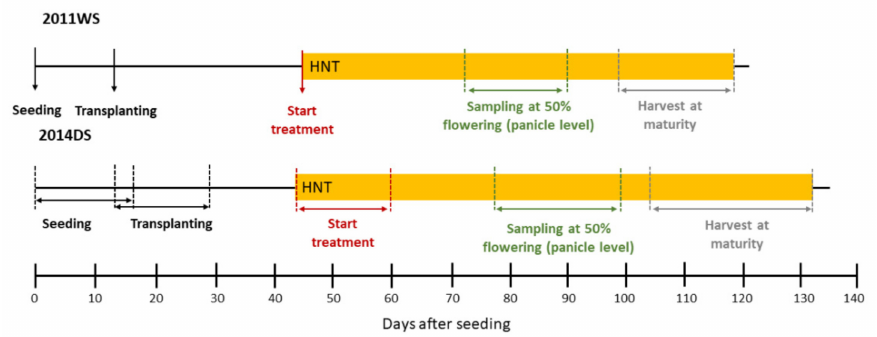
Figure A1. Experimental set-up for the DS and WS experiment. WS—wet season, DS—dry